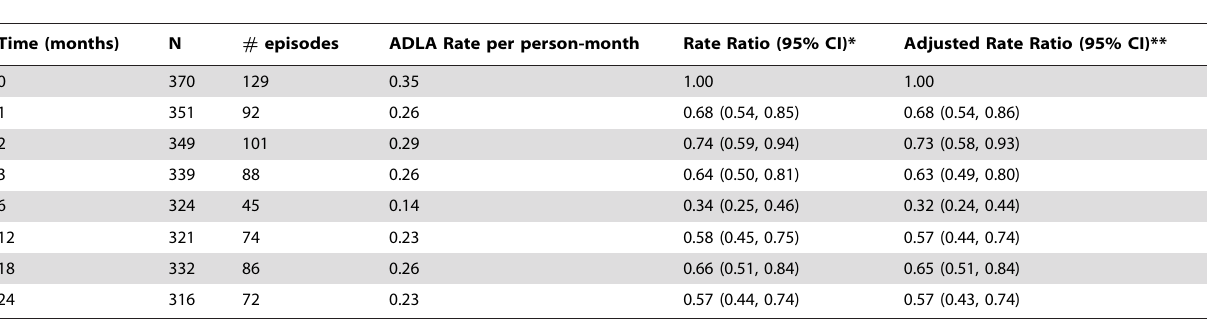
Table 2. 30-day rate of ADLA over time among lymphedema management